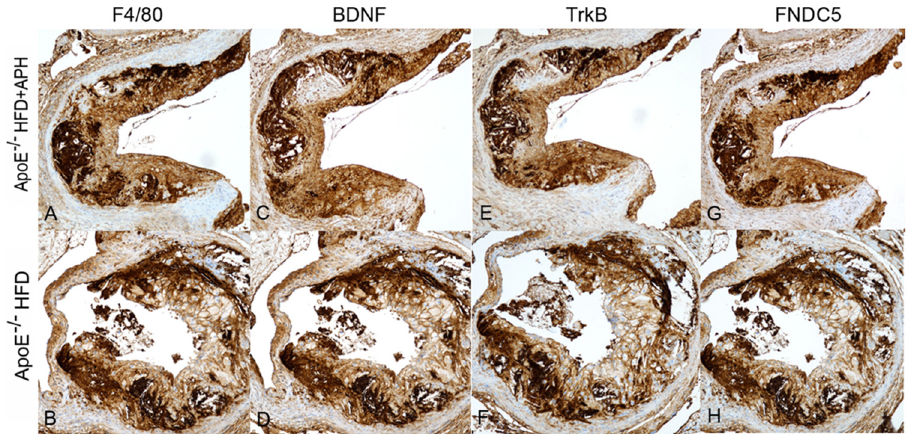
Figure 5. Immunohistochemical characterization of atherosclerotic plaques in aortic sinus of ApoE − / − HFD+APH and ApoE − / − HFD (control) mice. Representative photomicrographs of F4/80 expression ( A , B ). Representative photomicrographs of BDNF ( C , D ), TrkB ( E , F ), and FNDC5 ( G , H ) expression in atherosclerotic plaques (magnification 10×).